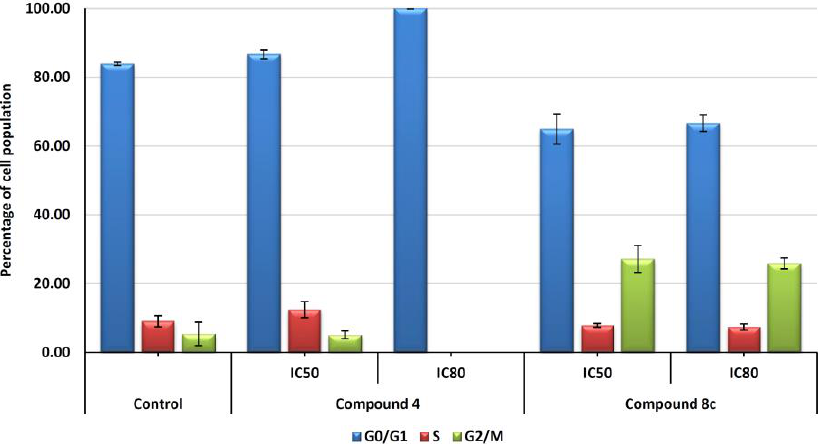
Figure 3. Cell-cycle phase representation (%) with respect to untreated control cells. Hep-G2 cells were treated with compounds 4 and 8c for 72 h at IC 50 and IC 80 concentrations. Cells in the G0/G1 phase (blue bars), S phase (orange bars), and G2/M phase (green bars) were counted. Values represent means ± S.E.M. of at least two independent experiments performed in triplicate.